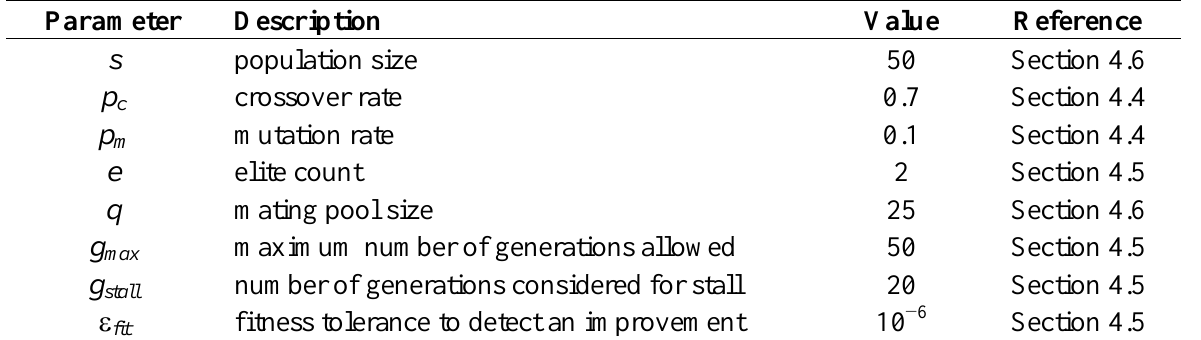
Table 4. Parameters of the algorithm and their typical